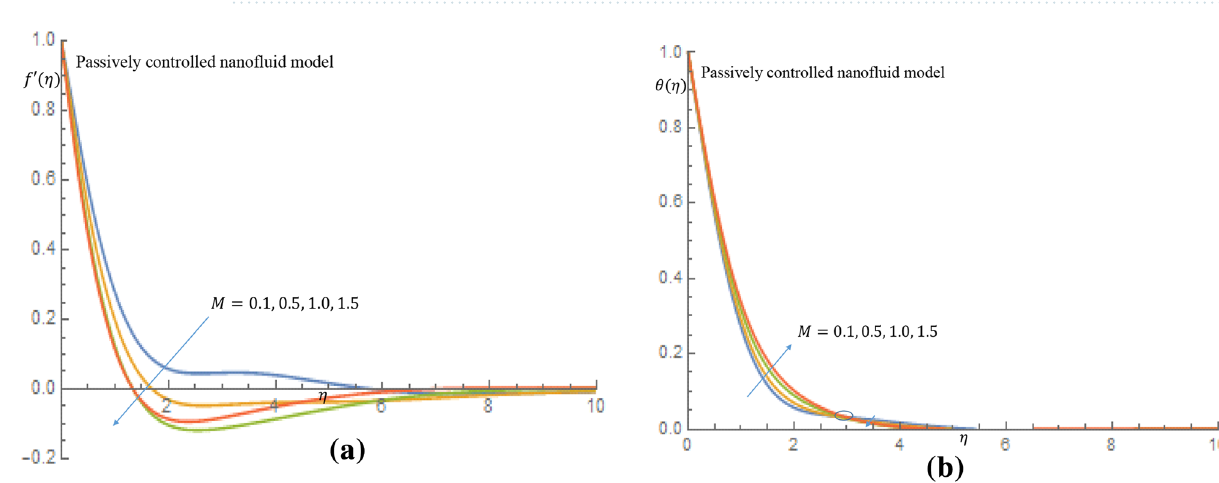
Figure 3. ( a ) Effect of M on velocity profile when G r = 1.0 . ( b ) Effect of M on temperature profile when G r = 1.0